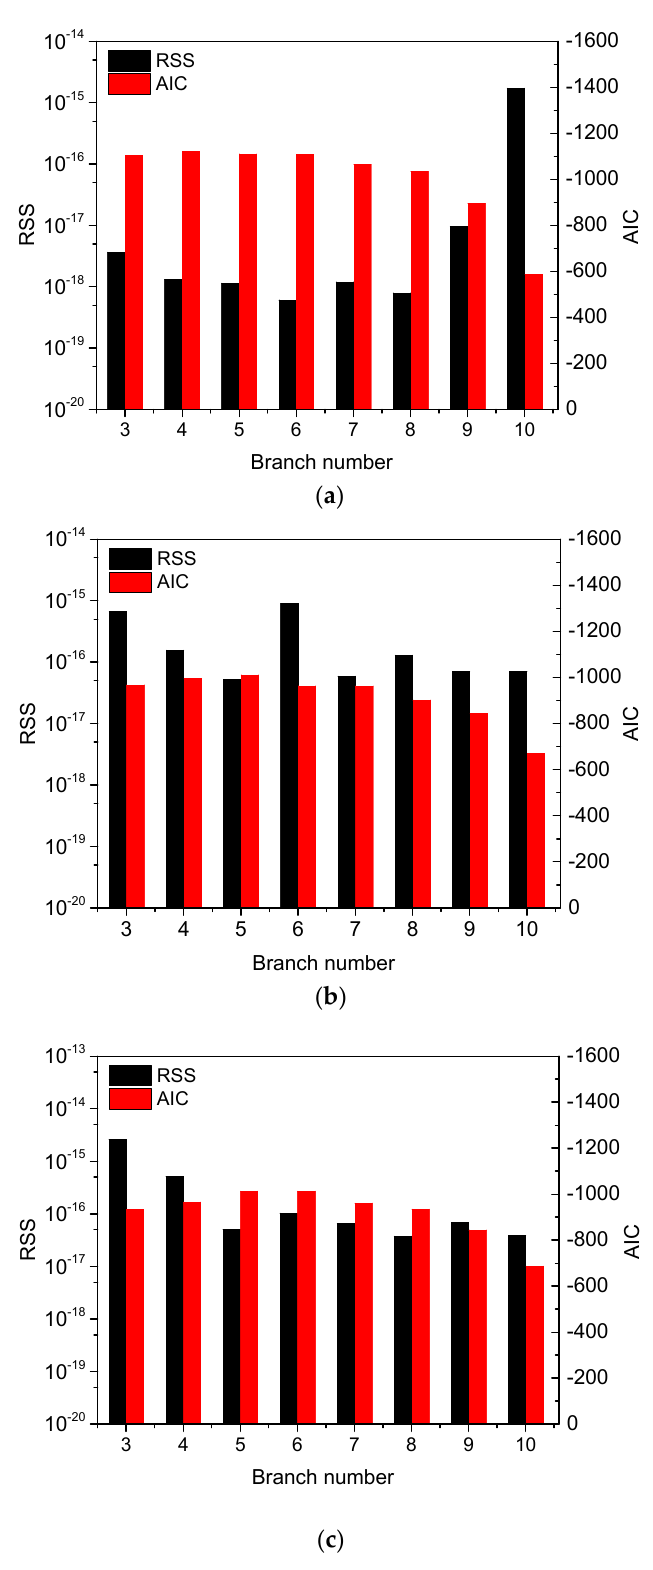
Figure 6. The residual sum of squares ( RSS ) and Akaike information criterion (AIC) values of the parametrization results with different branch numbers under the three controlled temperatures: ( a ) 30 °C; ( b ) 70 °C; ( c ) 80 °C.